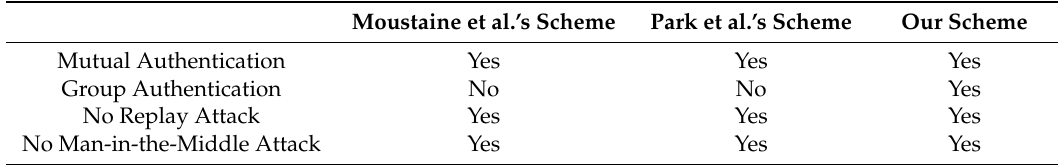
Table 2. Feature and security